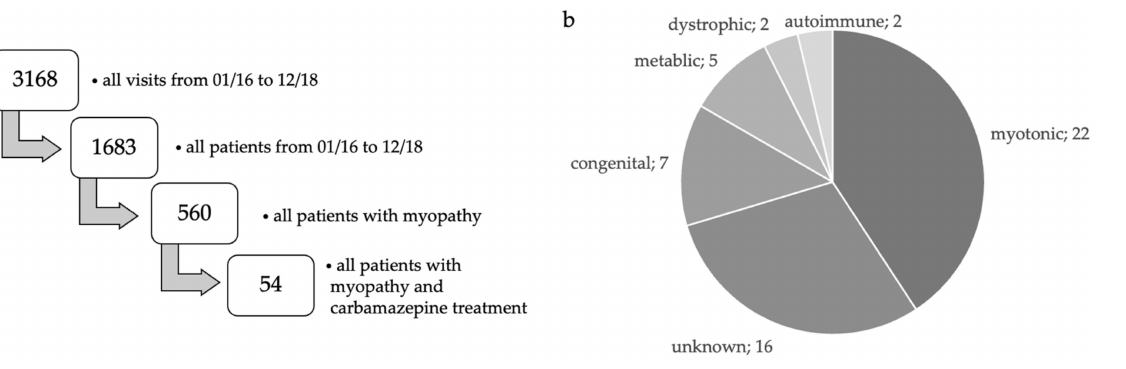
Figure 1. ( a , b ). Study collective. ( a ) Screening process and selection of our study cohort. Out of 1683 patients and 3168 visits, 54 patients fulfilled our inclusion criteria, which were adult myopathy patients (>18 years) that were symptomatically treated with carbamazepine due to chronic muscle pain. Patients with carbamazepine treatment due to other indications were not included. ( b ) Overview of all included muscle diseases. The most frequent diagnoses were myopathies of unknown origin and cramp-fasciculation syndrome, including benign forms and neuromyotonia. We also included very rare diseases such as nemaline myopathy and central core